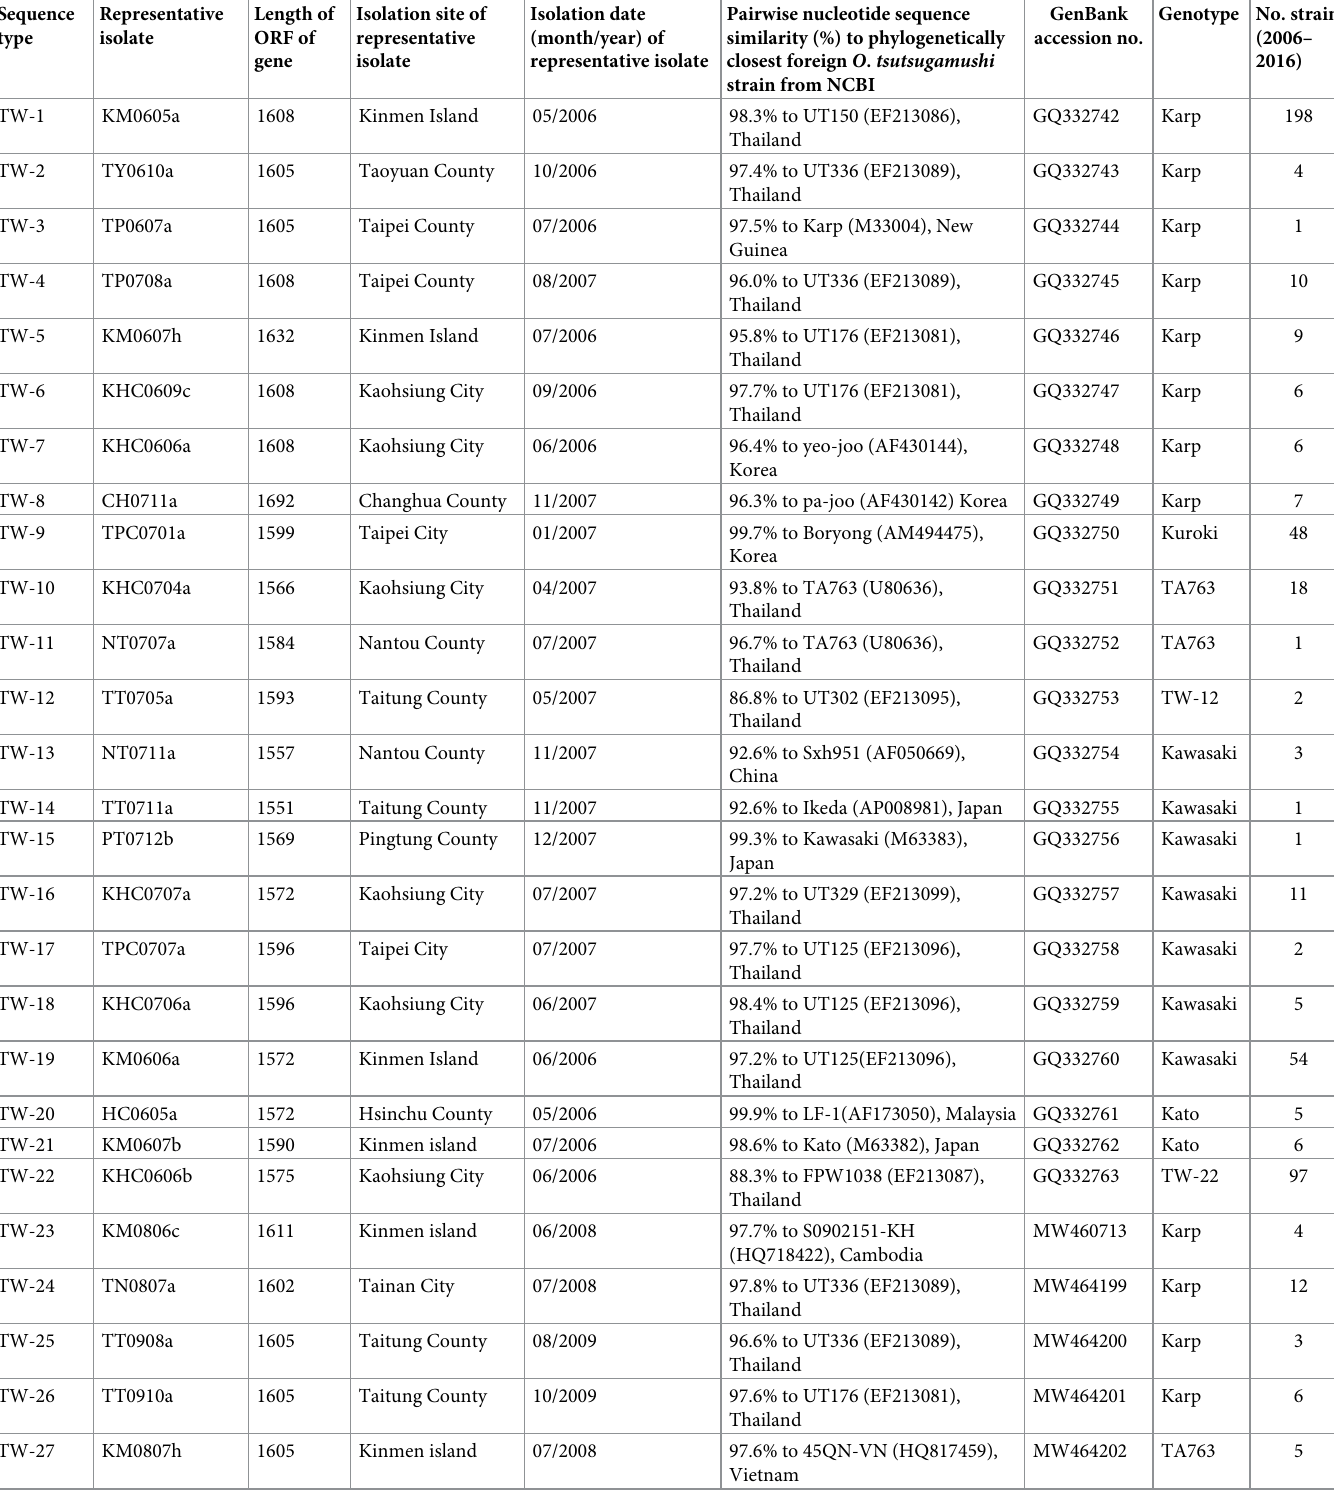
Table 1. The sequence type, representative strains, and phylogenetically closest foreign strains of Orientia tsutsugamushi . Sequence Representative type